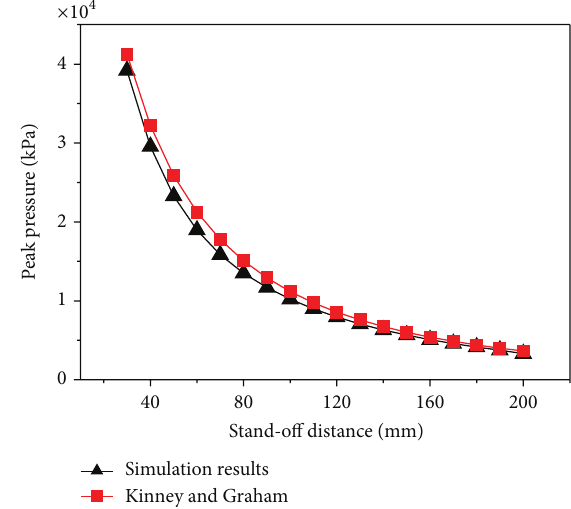
Figure 4: Peak pressure versus stand-off distance for simulation results and the fitting equation developed by Kinney and Graham [21].